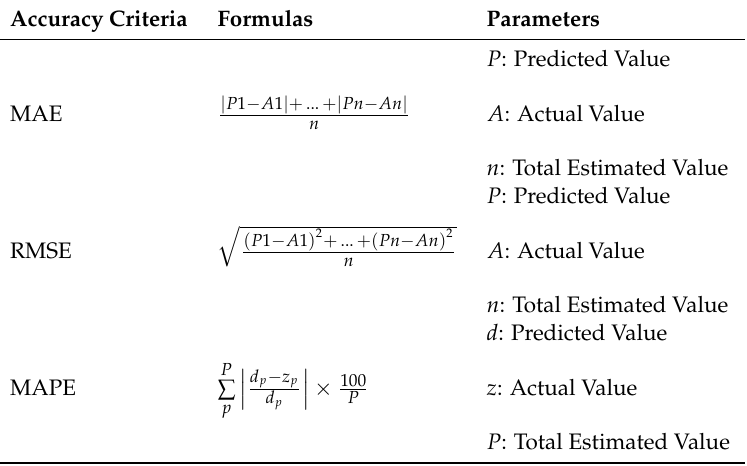
Table 4. Some error